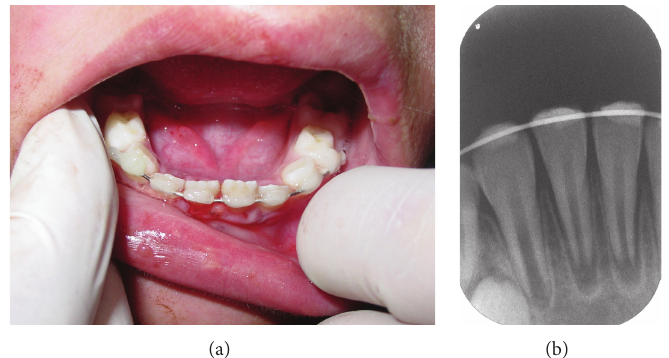
Figure 4: (a) Flexible splint made with resin composite and 0.7 mm orthodontic wire onto the labial surface of the teeth involved and the immediately adjacent teeth. (b) Radiographic of the injured area.